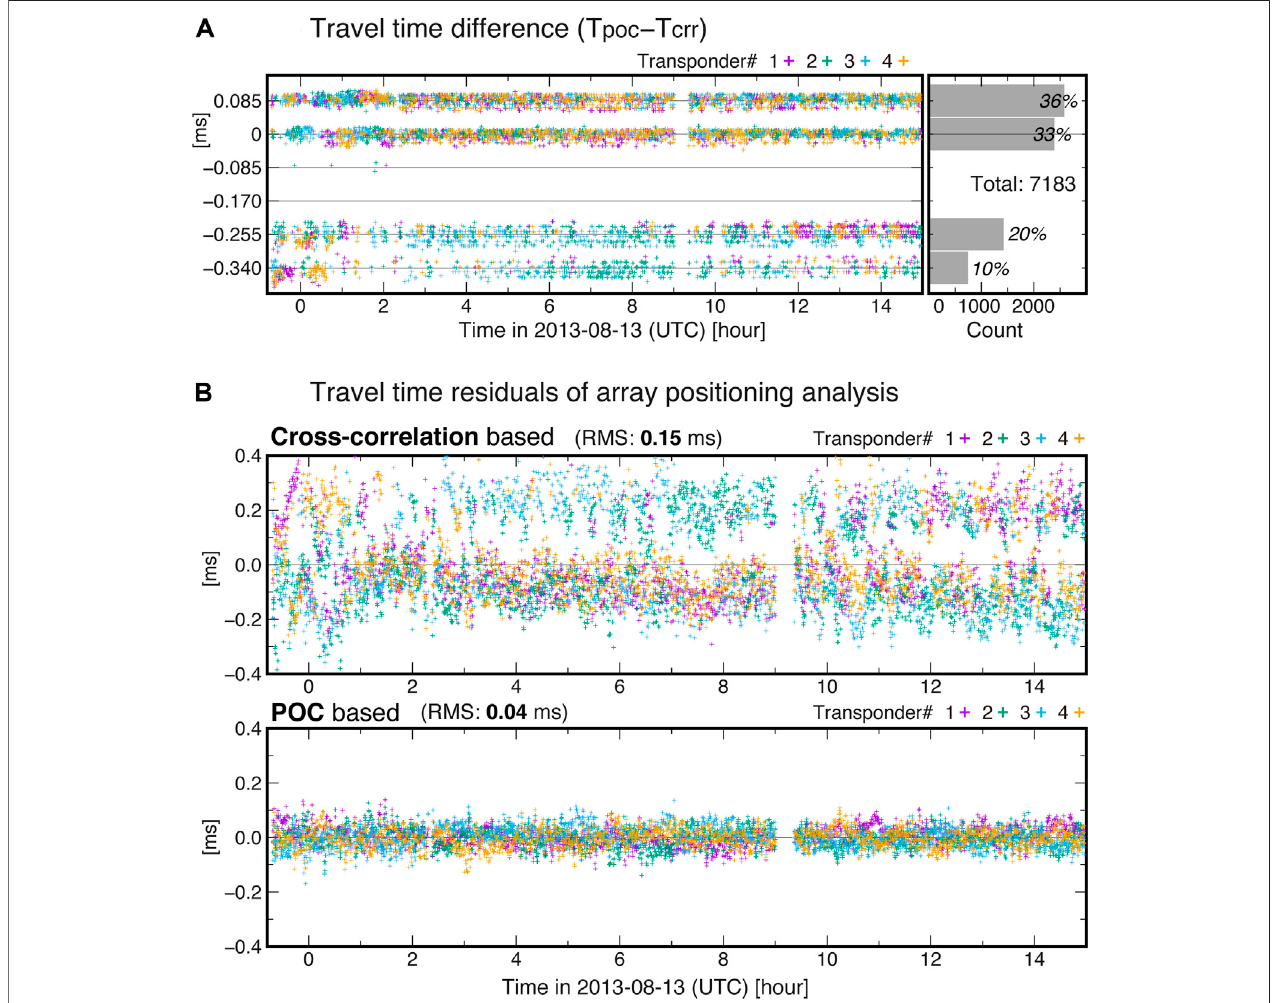
FIGURE7| Comparison oftraveltimes determinedusingthecross-correlation and POC templates. (A) Differenceoftraveltimes,shown inatimeseriesduring the ∼ 15 h observation period of Campaign #2 (left) and in a histogram (right). There were 4 transponders in the array, which are indicated by color. (B) Travel-time residuals (vertically normalized values) resulting from the array positioning analysis using the travel-time data determined with the cross-correlation (upper) or those with the POC (lower). Color indicates the transponder number.